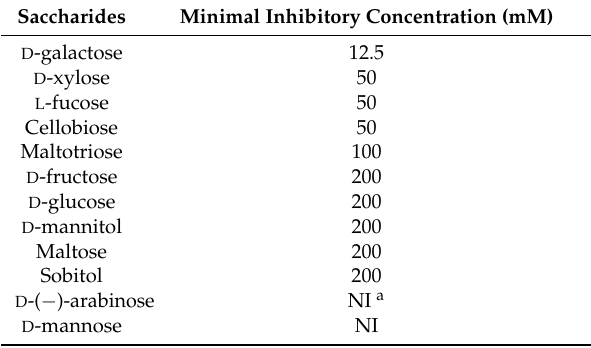
Table 3. Effects of saccharides on hemagglutinating activity of rLycCTLR.